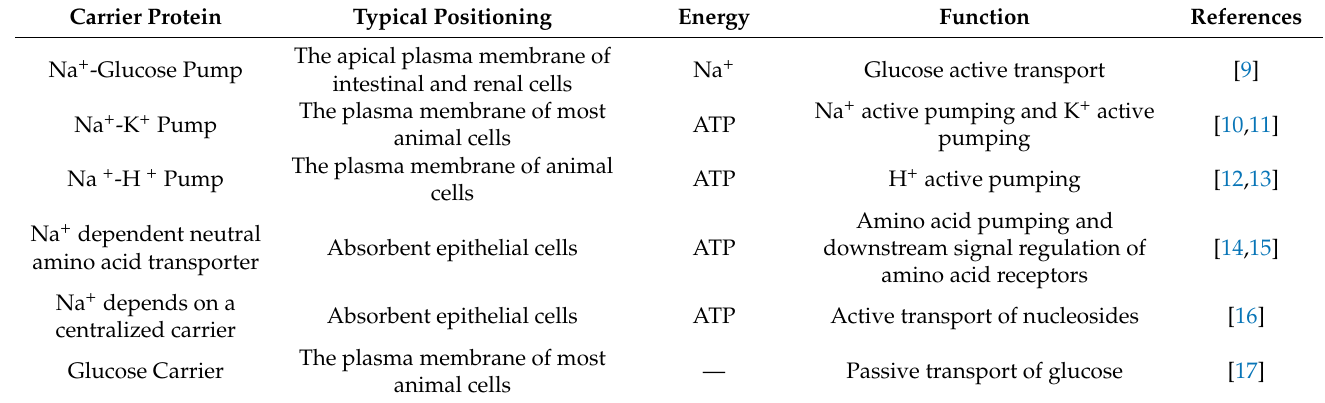
Table 1. Summary of the properties of common carrier proteins in animal